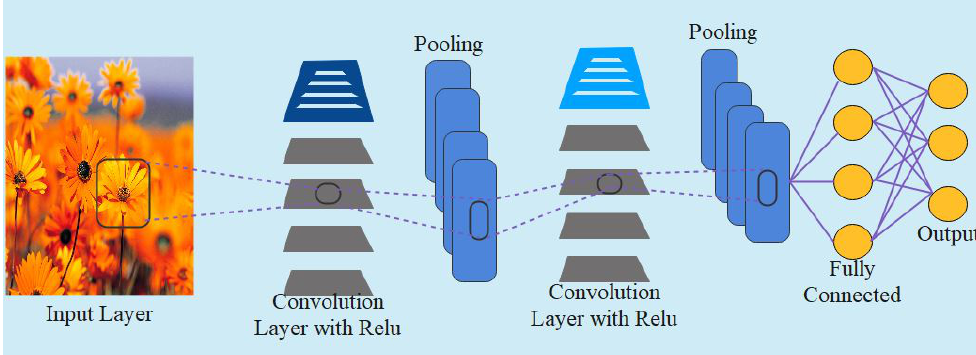
Figure 6. The Structure of Convolutional Neural Network